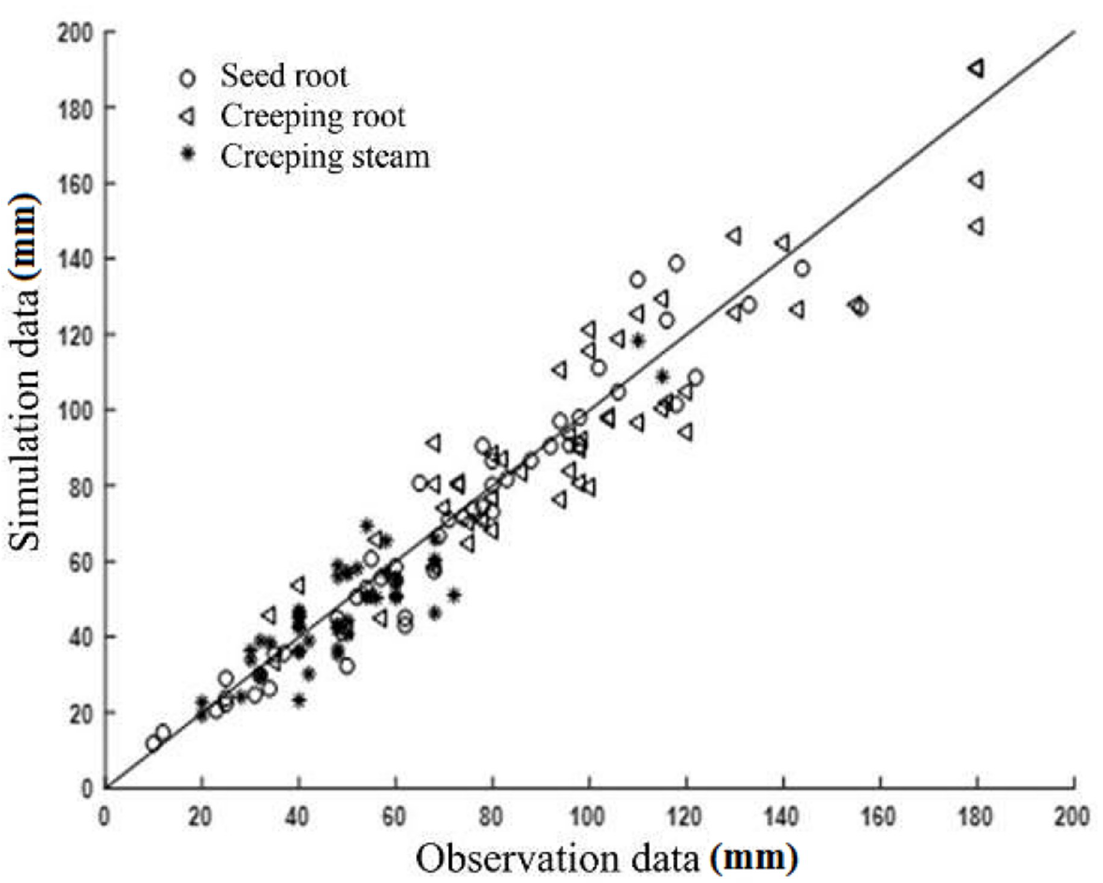
Fig 18. Comparison of measured and simulated values of